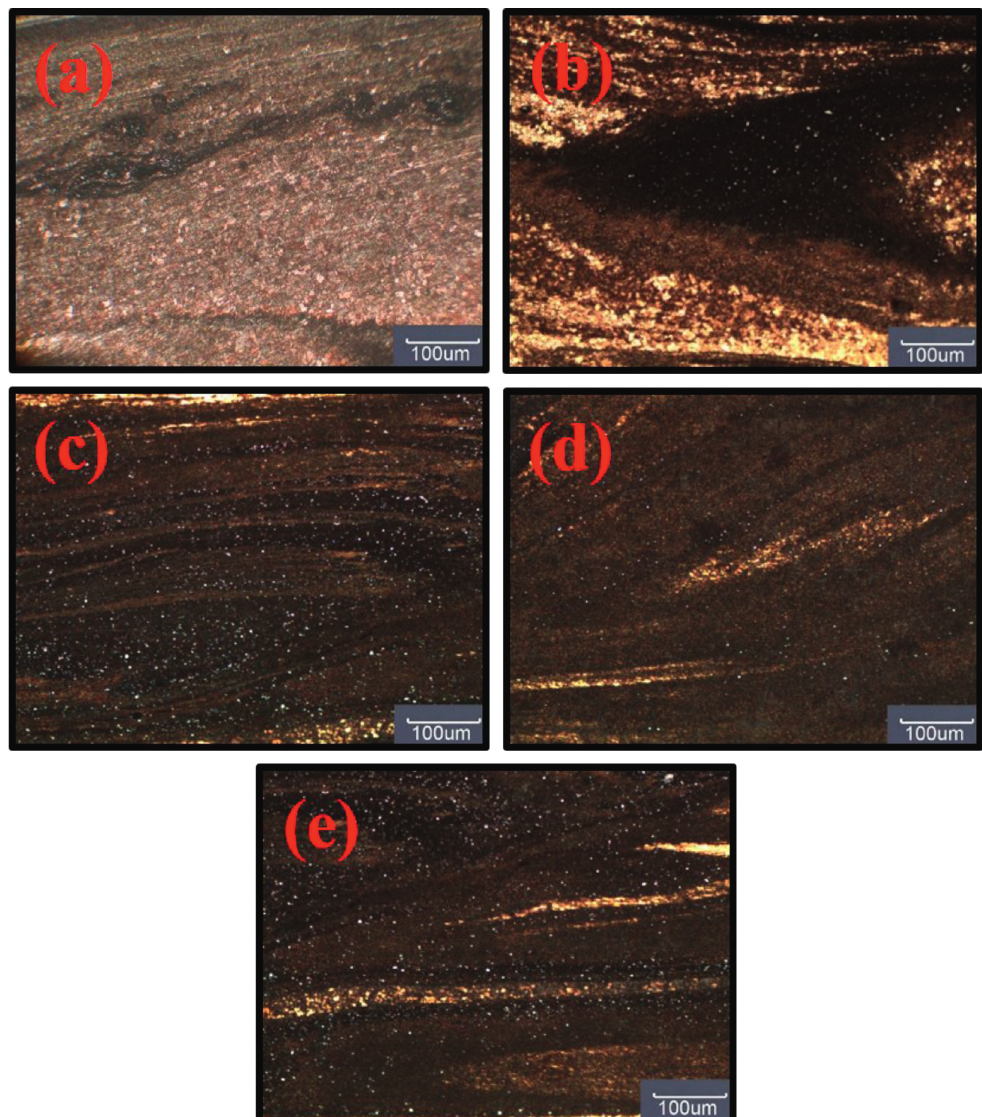
Figure 7: Optical microscopic images of stir zone at various tool rotational speeds of (a) 1000rpm, (b) 1100rpm, (c) 1200rpm, (d) 1300rpm, and (e) 1400rpm.